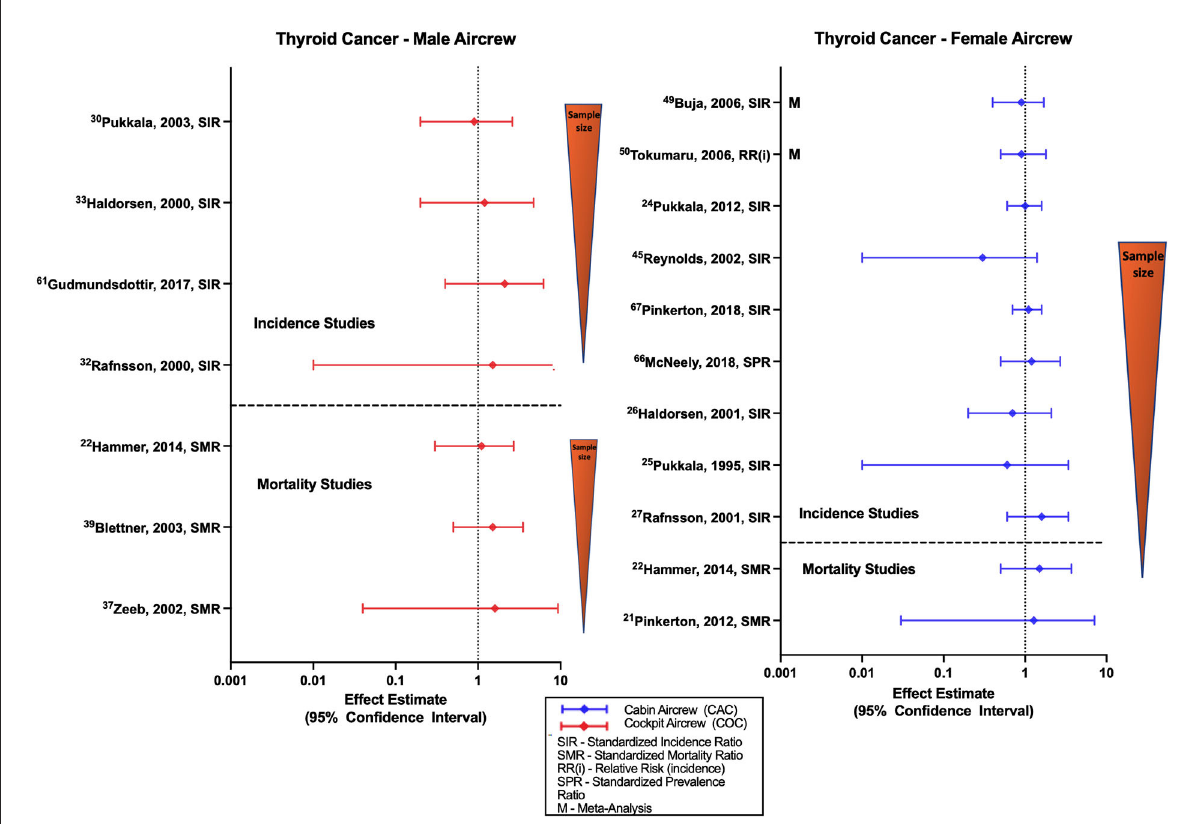
FIGURE7 Forest plot for studies evaluating thyroid cancer incidence or mortality ratios among male (left hand side graph) and female aircrew (right hand side graph) in association to CIR exposure.